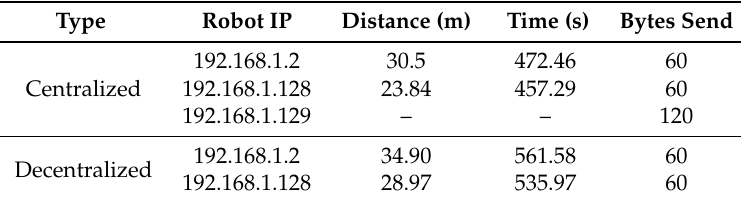
Figure 8. Topological map processed by two robotic agents. Table 6. Results from the experiment with two robotic